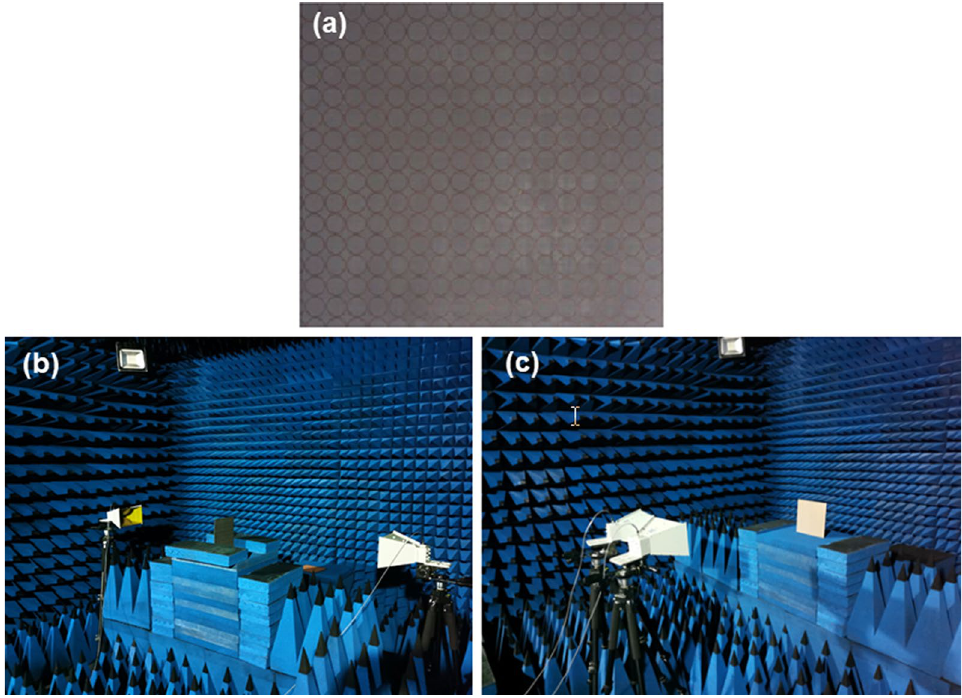
Figure 10. ( a ) Photograph of the fabricated sample; ( b , c ) photographs of the experimental